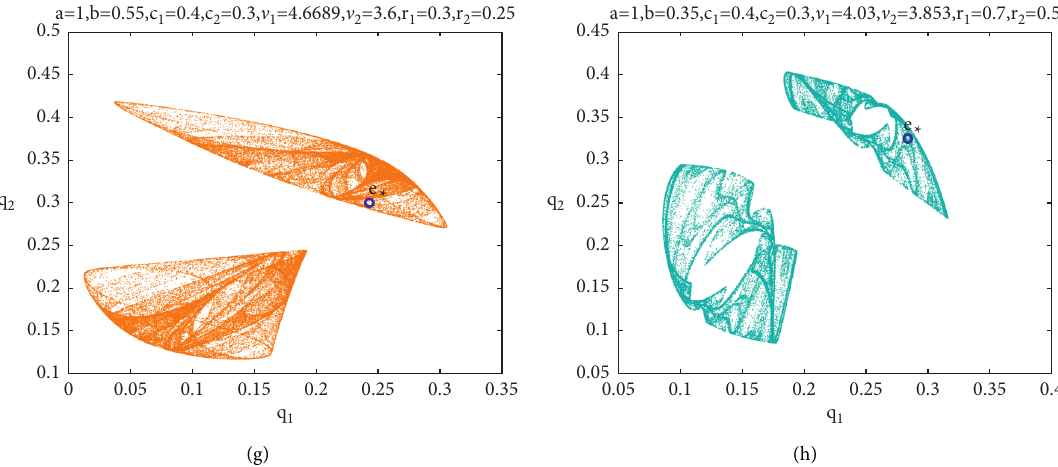
Figure 1: (a)–(d) 1D bifurcation diagram on varying both v � 3 . 852) on varying v v (or on varying v 2 2 v � 3 . 33, and v � 3 . 852. (f) The phase plane of one-piece chaotic attractor at a � 1 ,b � 0 . 35 , c 1 2 � 0 . 5 , v � 4 . 5696, and v � 3 . 852. (g) Two-piece chaotic attractor at a � 1 , b � 0 . 55 ,c r 2 1 2 � 3 . 6. (h) Two-piece chaotic attractor at a � 1 , b � 0 . 35 ,c and v 2